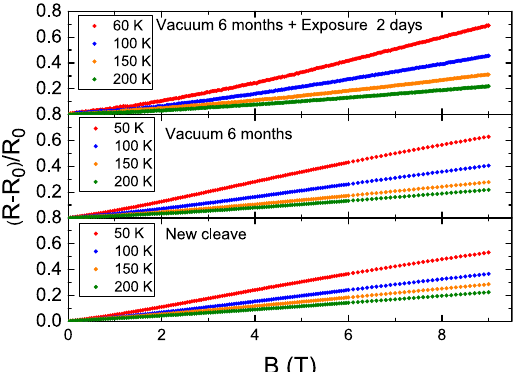
Figure 2. Temperature dependence of MR slope for newly cleaved, 6-months in vacuum, and 2-days N 2 exposed samples. The MR slope increases as temperature decreases. N 2 exposure does not completely smear out the non-saturated magnetoresistance. Smaller MR slopes are seen at longer exposure times.